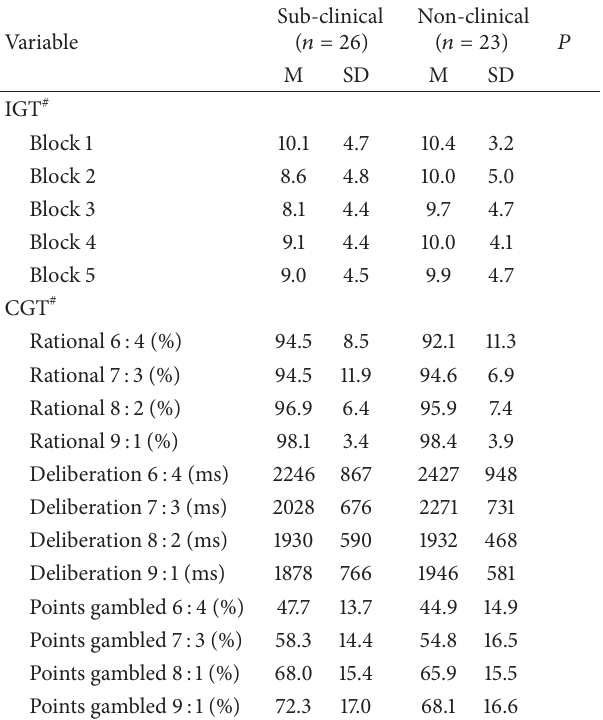
Table2:Meansandstandarddeviationsinthesub-clinicalandnon- clinical groups for the IGT and CGT task measures.